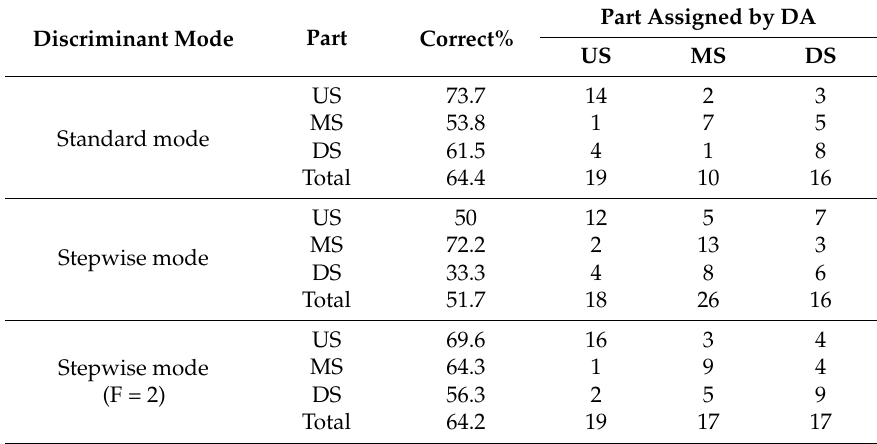
Table 6. Verification and classification functions for DA of spatial